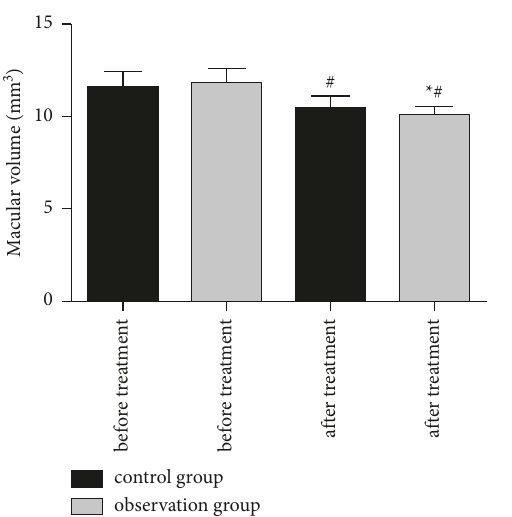
Figure 6: MCP-1 levels of two groups of patients at different times. Compared with the same group before treatment, # P < 0 . 05; compared with the control group, ∗ P < 0 . 05.